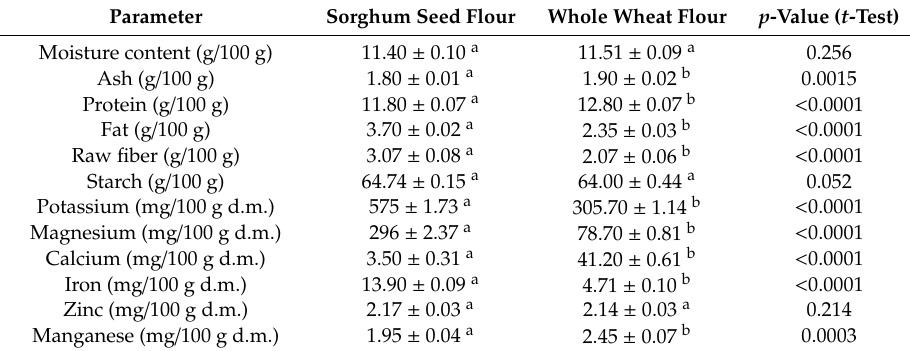
Table 3. Chemical composition of sorghum and whole wheat